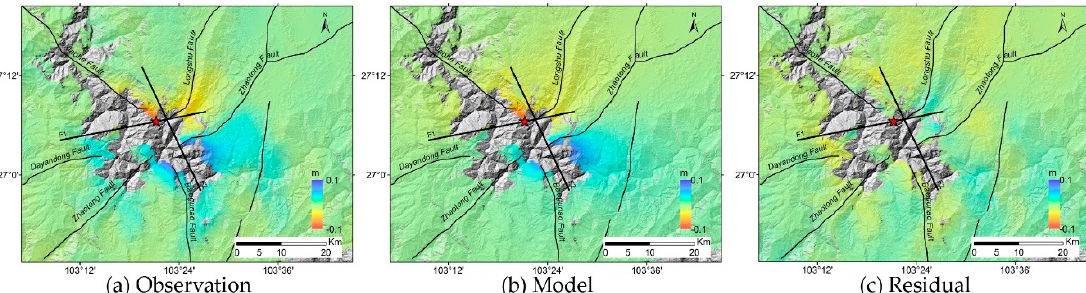
Figure 4. Coseismic displacement (negative indicates range displacement away from the satellite) and model for the distribution slip inversion of the 2014 Ludian earthquake: ( a ) the observed line-of-sight (LOS) displacements for the interval from 4 March, 2014 to 16 April, 2015; ( b ) the synthetic LOS displacement; and ( c ) the residual displacement.